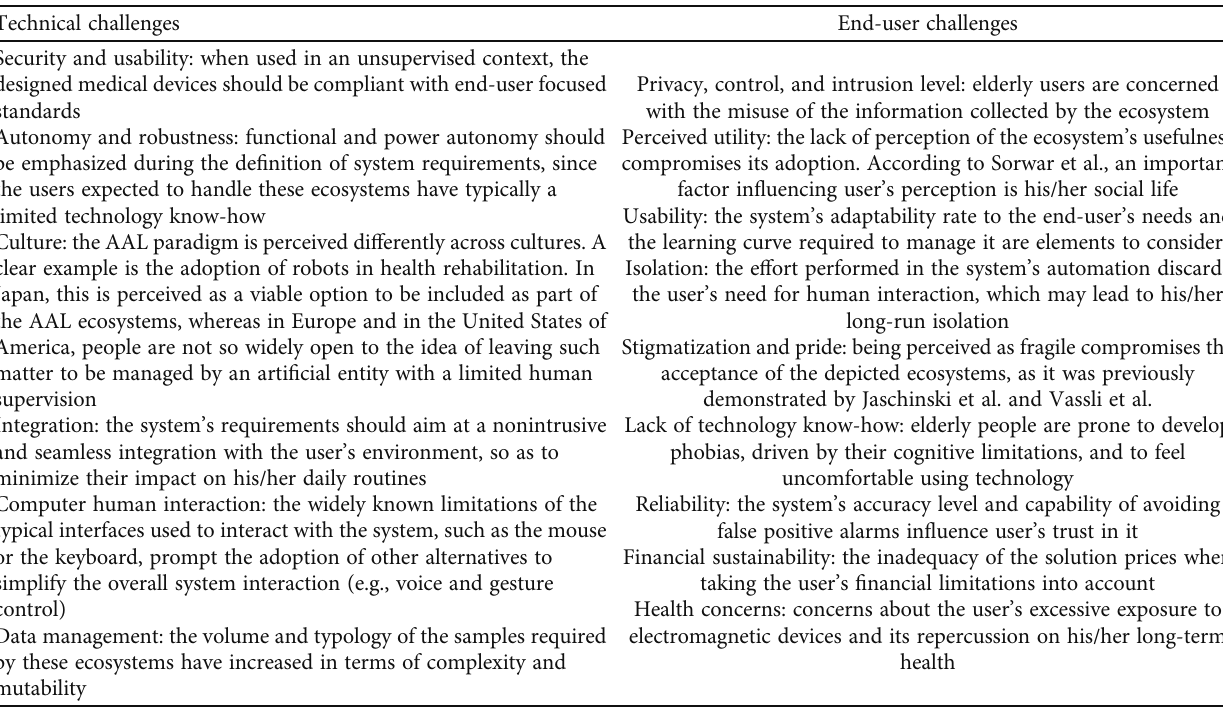
Table 1: AAL ecosystem challenges [5 –